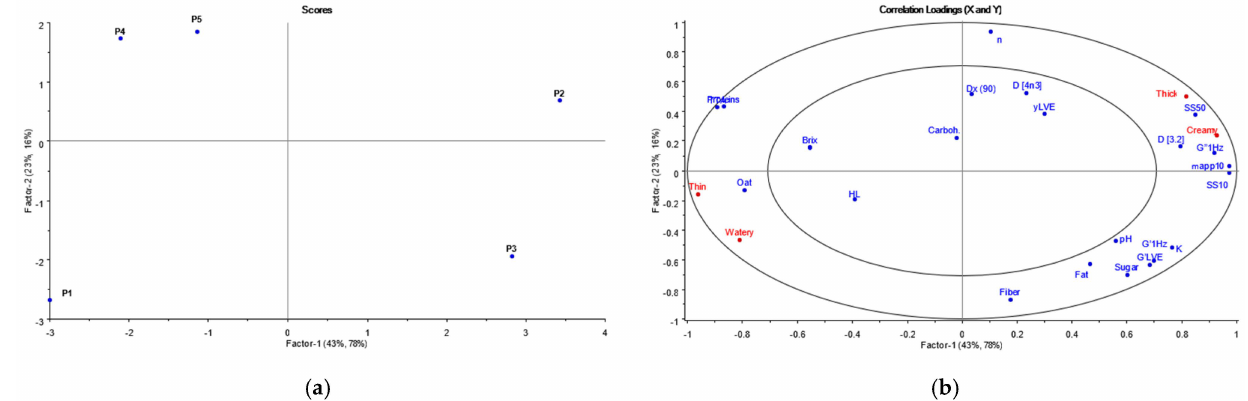
Figure 5. PLS regression bi-plots for scores ( a ) and for loadings ( b ) of sensory and physicochemical parameters for five plant-based yogurts. The abbreviations of physicochemical parameters are in accordance with Table